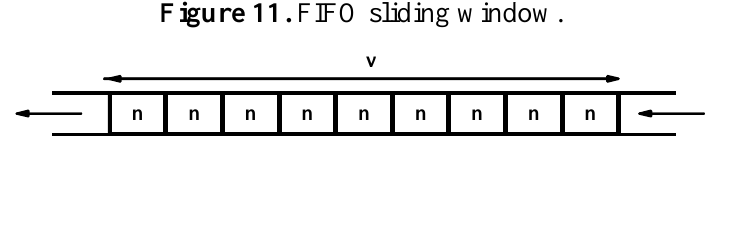
Figure 11. FIFO sliding